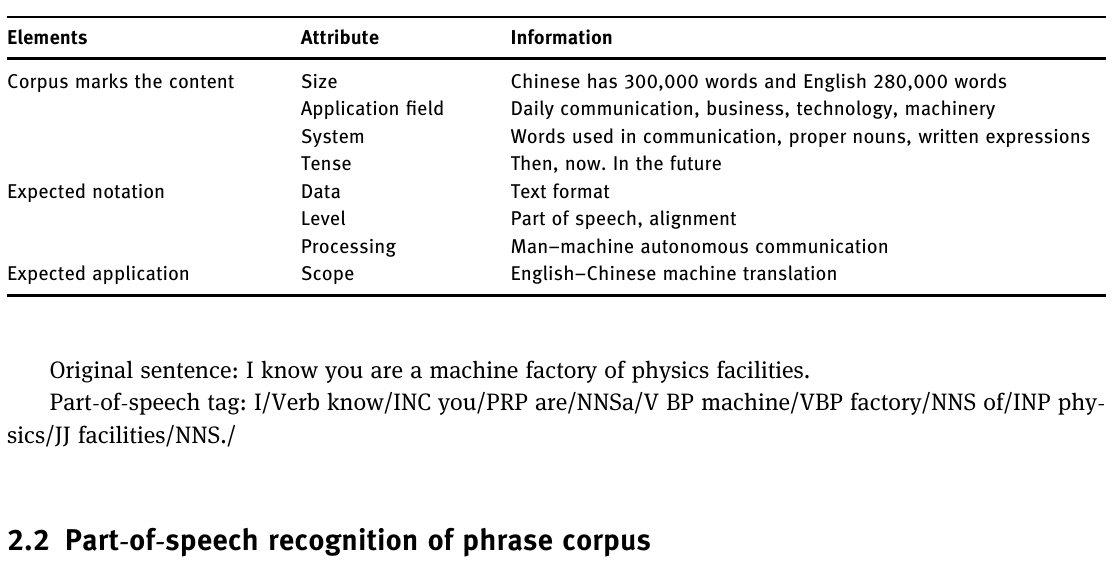
Table 1: Phrase corpus